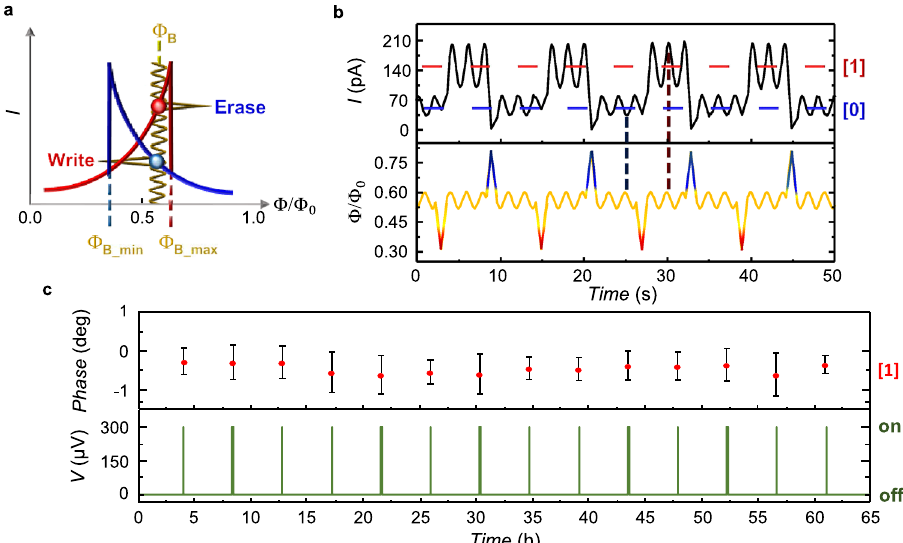
Fig. 4 Operation of the phase-slip memory with AC readout. a Sketch of the memory operation in the presence of a sinusoidal fl ux oscillation ( Φ AC , yellow trace) around Φ B 2 ð Φ 0 = 2 ; Φ B max Þ . b Evolution of the readout current (top panel) measured at V = 300 μ V and Φ composed by a fl ux bias ( Φ B =